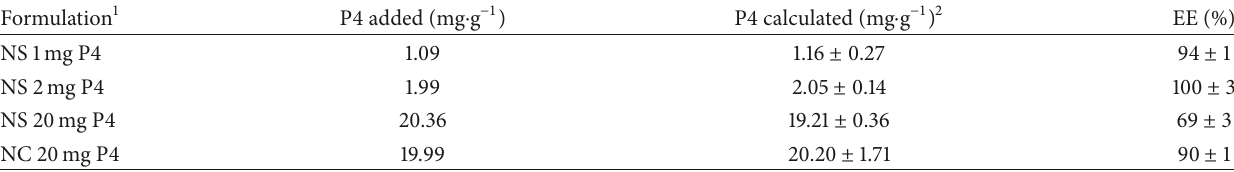
Table 7: Added and calculated P4 concentration and encapsulation efficiency (EE) in PMMA nanoparticles. Formulation 1